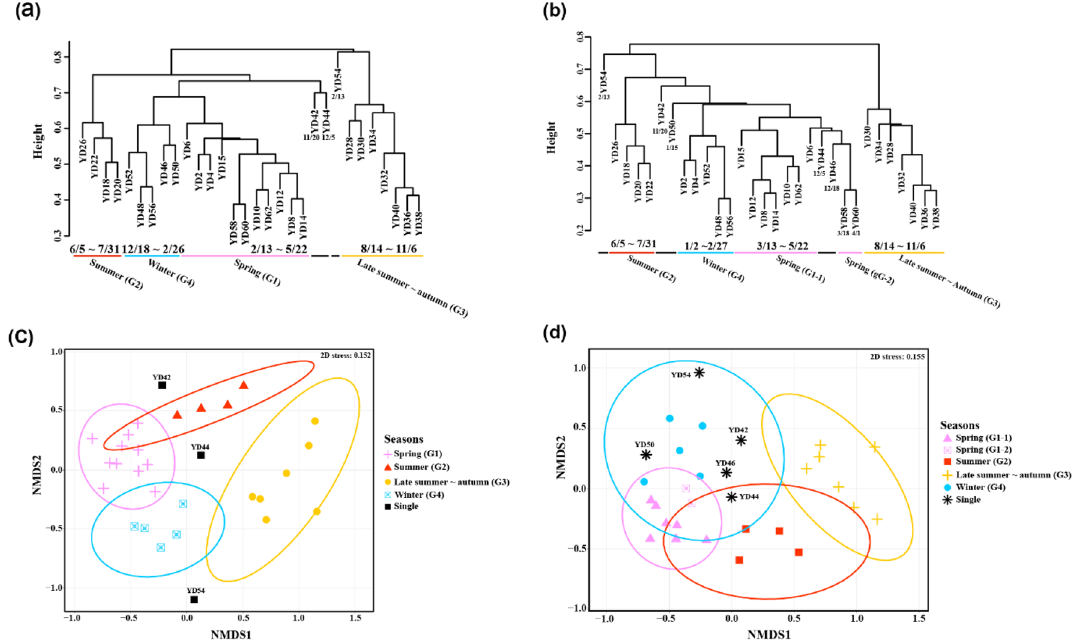
Figure 6. Results of the clustering analysis. Cluster dendrogram of ( a ) “total” zooplankton and ( b ) “common” zooplankton. NMDS plot of ( c ) “total” zooplankton and ( d ) “common” zooplankton. The colors of